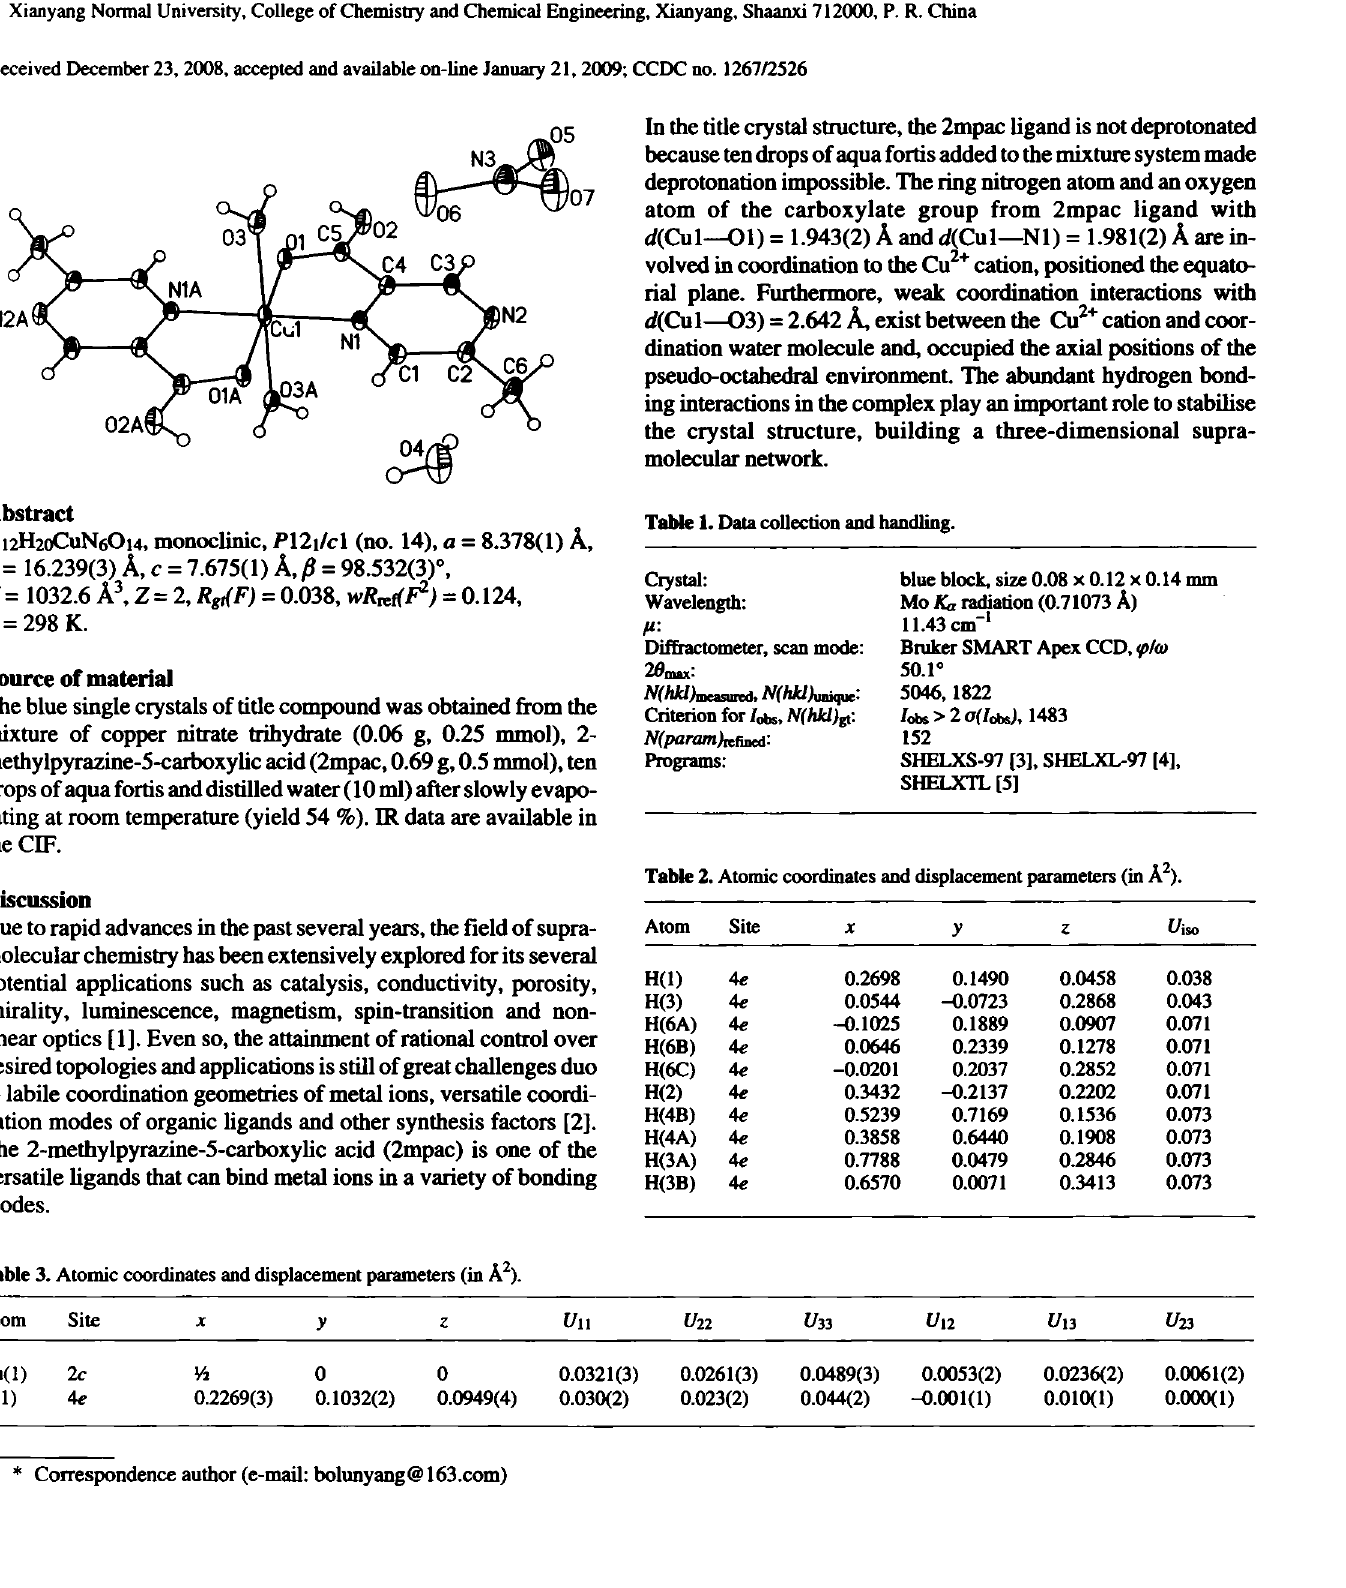
Table 3. Atomic coordinates and displacement parameters (in Â 2